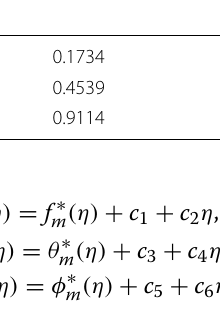
in the absence of nanoparticle for different θ ′ ( 0 ) − 0, β Pp Fs S δ 1 δ 2 (cid:31) (cid:30) = = = = = = → ∞